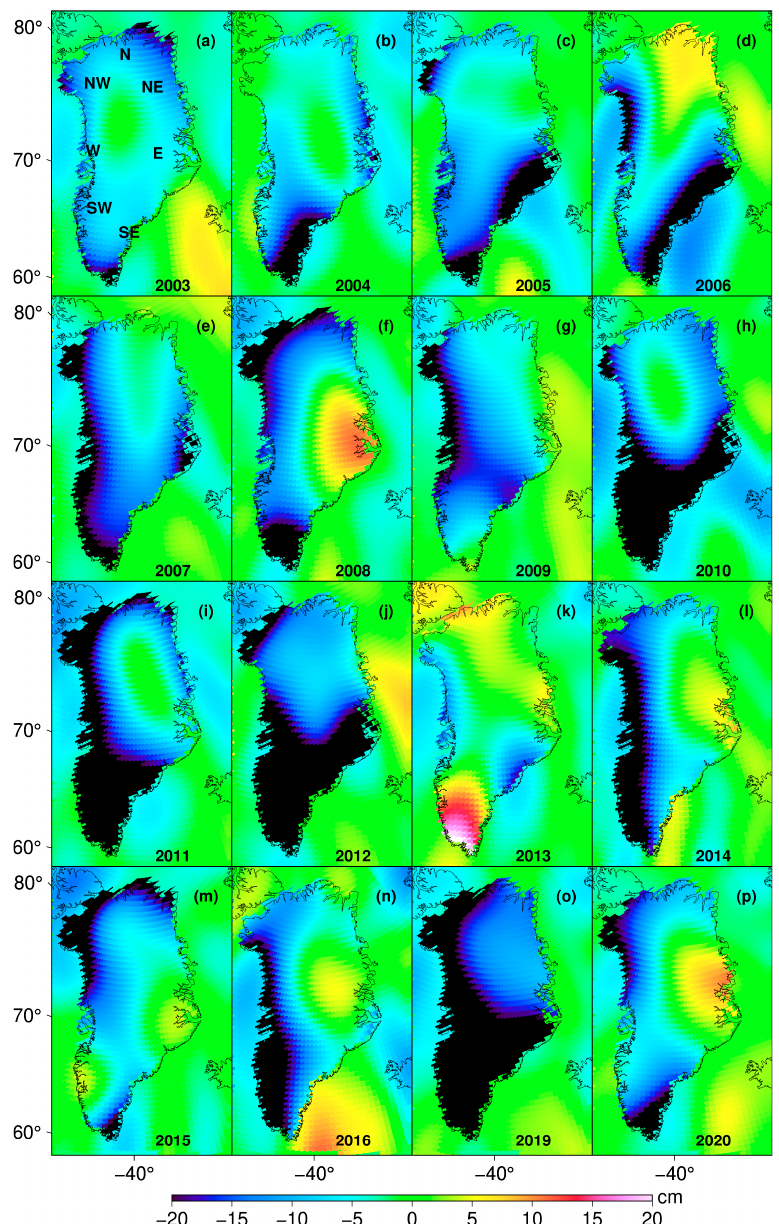
Figure 6. Spatial distribution of annual mass variations of the GrIS during the period from 2003 to 2020 (excluding 2017 and 2018). The spatial distribution of annual mass variation over GrIS from 2003–2006 ( a – d ), 2007–2010 ( e – h ), 2011–2014 ( i – l ), 2015–2020 ( m – p , excluding 2017 and